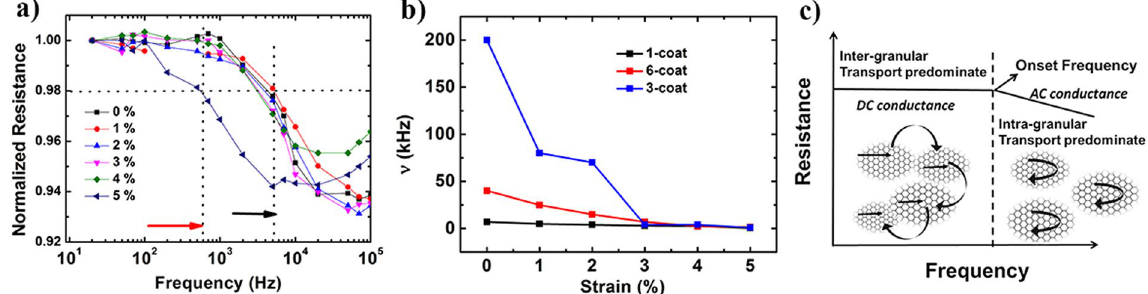
Figure 6. ( a ) Frequency response of 1-coat rGO-PDMS film under different strain values (red arrow marks the onset frequency for 5% of applied strain and black arrow marks the onset frequency for all other lower strain values). ( b ) Variation of onset frequency as a function of applied strain for rGO films with different number of coats. ( c ) Schematic to illustrate the dominant mode of frequency-dependent transport, before and after the onset frequency.